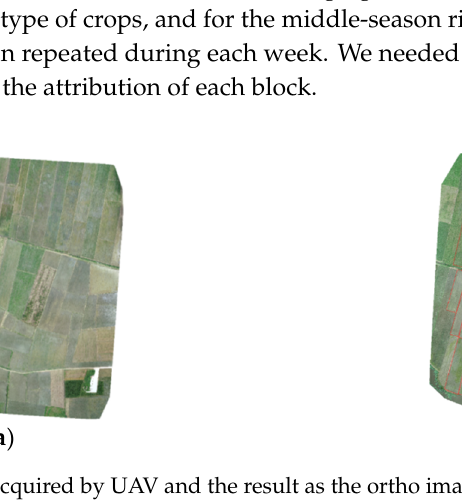
Figure 2. The seven phenological stages for village 1 in Xiantao. ( a ) The transplanting stage acquired on 13 June 2018; ( b ) the tillering stage acquired on 13 July 2018; ( c ) the booting stage acquired on 19 July 2018; ( d ) the heading stage acquired on 3 August 2018; ( e ) the milk stage acquired on 16 August 2018; ( f ) the dough stage acquired on 30 August 2018; ( g ) the maturity stage acquired on 11 September 2018.